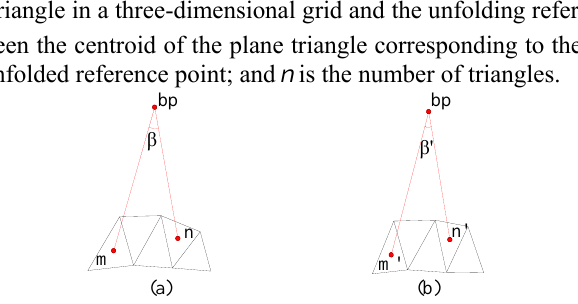
Fig. 4. Relative orientation deformation of triangle: (a) the graph before flattening, the directional angle between triangle m and n is  , (b) the graph after flattening, the directional angle between triangle ' m and ' n is ' 